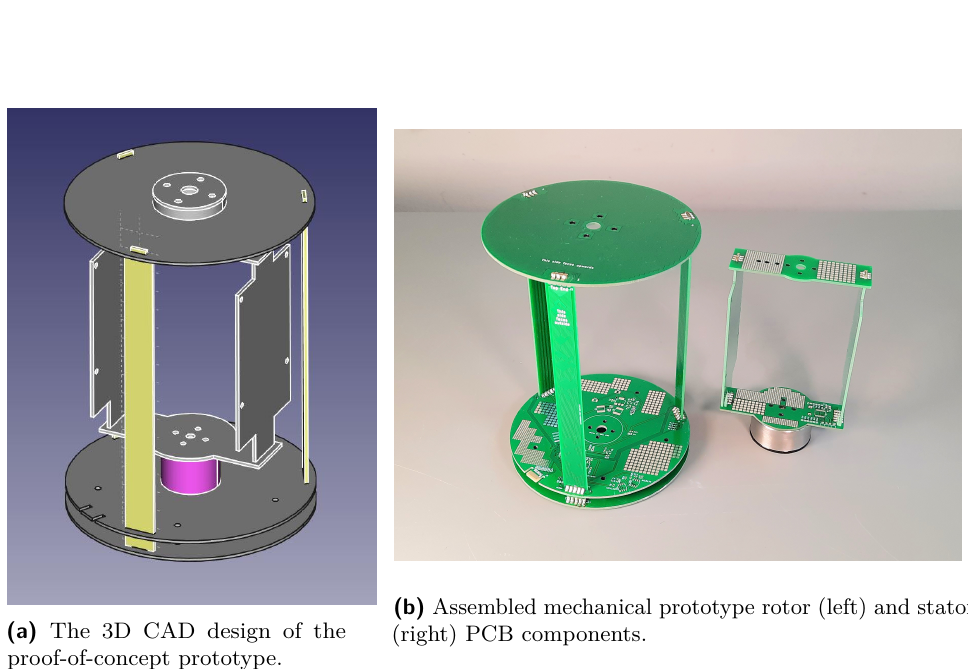
Figure 5: Our proof-of-concept prototype IHSM’s PCB security mesh design